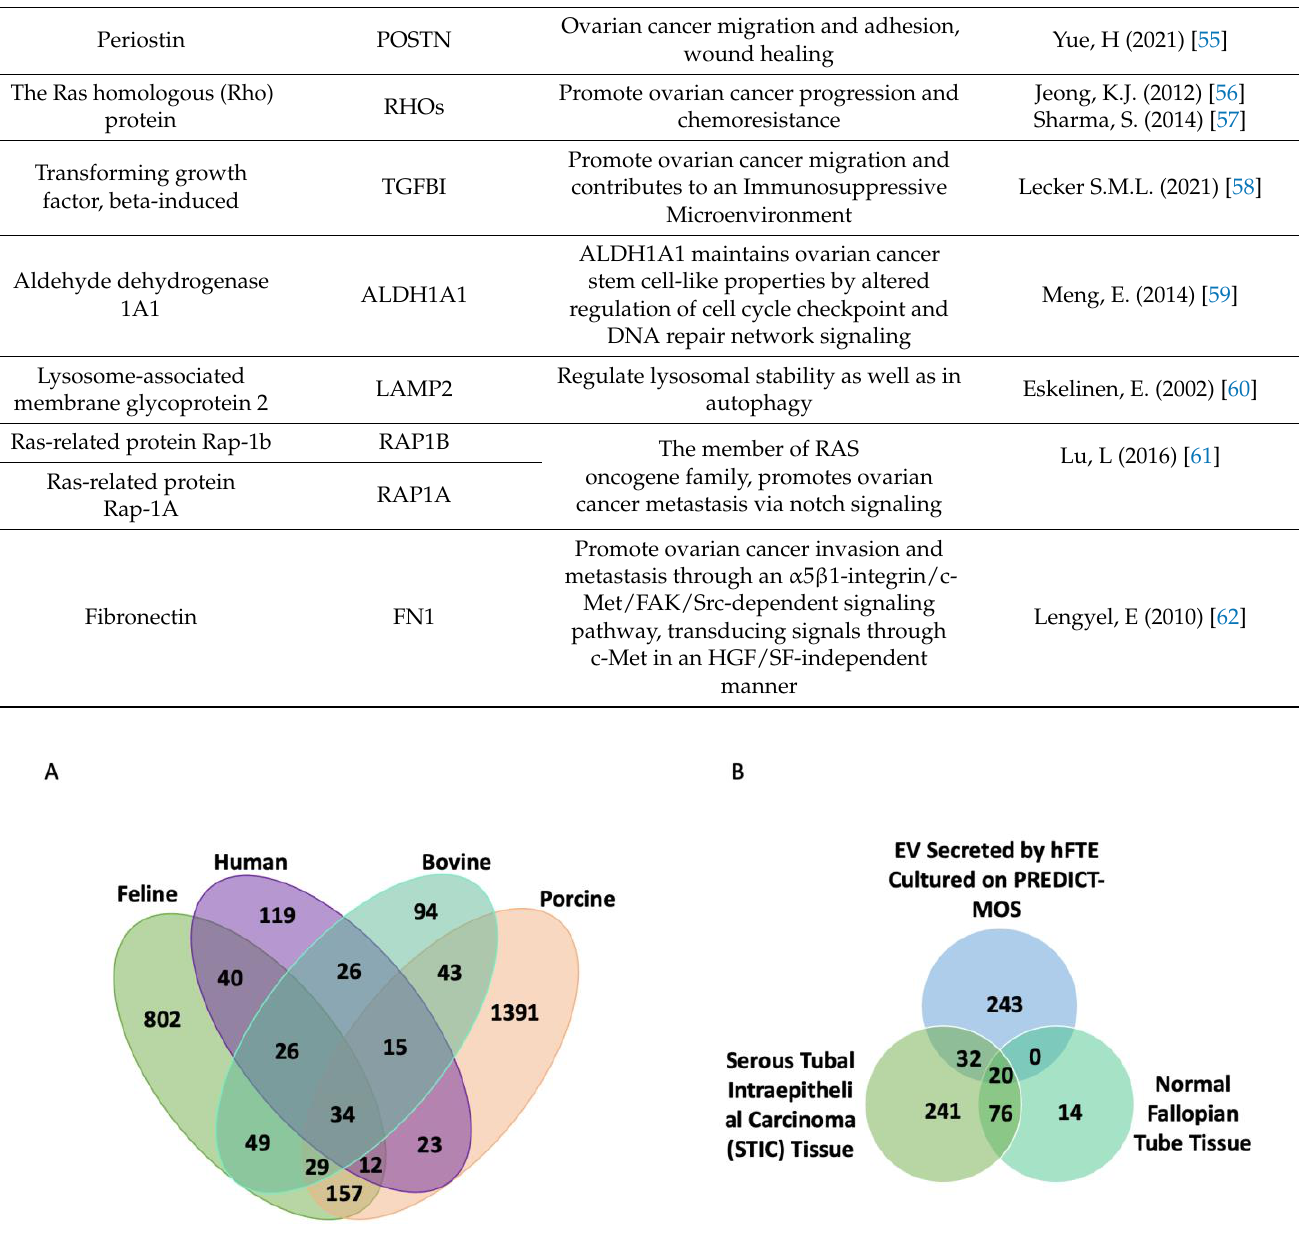
Figure 4. hFTE sEV protein content comparison across species and FT lesions. ( A ) Venn diagram showing the number of sEV proteins identified exclusively in human fallopian tube epithelium (hFTE), bovine, porcine, cat oviduct, or in common [3,33,34]. ( B ) Venn diagram showing shared proteins identified in STIC tissue [35] and proteins found in hFTE-derived sEVs cultured in the microfluidic device, PREDICT-MOS.